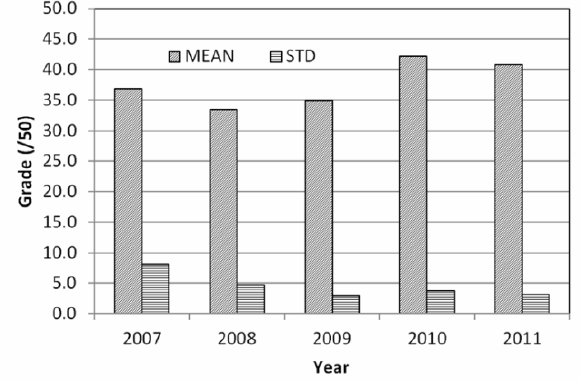
Figure 3. The Mean and Standard Deviation of overall final grades of student in the first semester capstone research subject